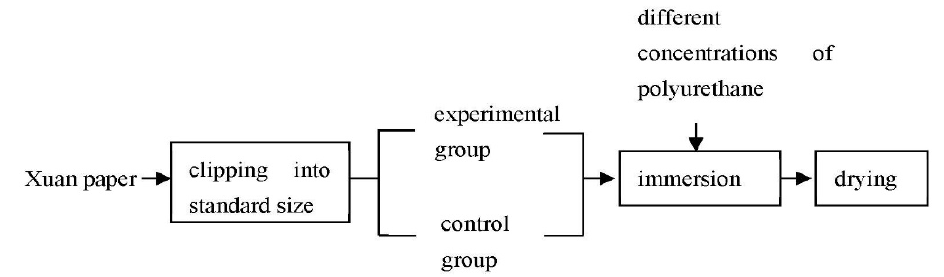
Figure 1. Coating